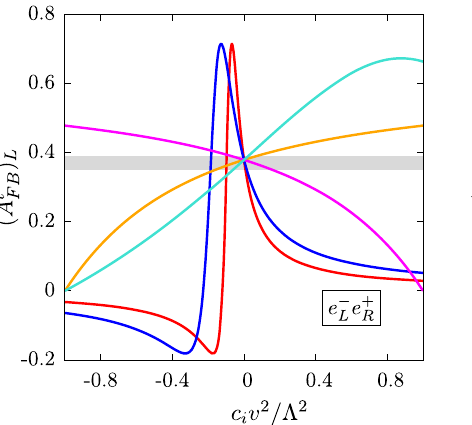
Fig. 5 Full dependence of the t ¯ t forward–backward asymmetry of Eq. (V.1) on the operators of Eq. (II.4) for left-handed polarised elec- trons ( left ) and right-handed polarised electrons ( right ) at